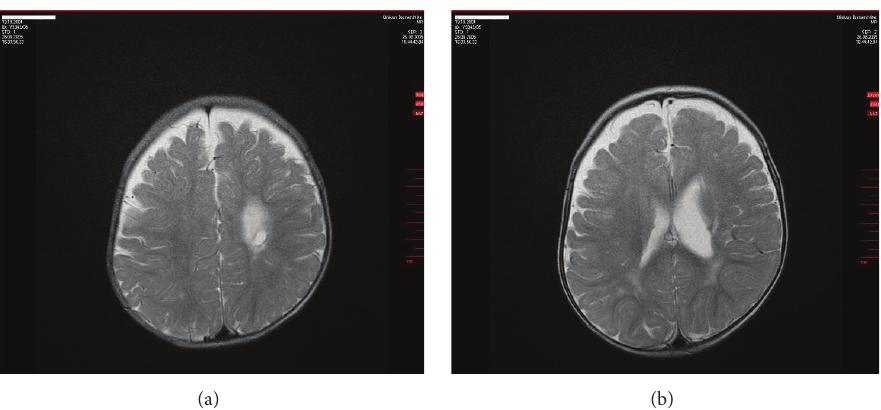
Figure 2: MRI of the brain (M.H.) at 10 months of age (2005). Left ischemic stroke in the central and paraventricular white matter resulting in a porencephalic cyst and enlarged lateral ventricle (1.5-Tesla Avanto, head coil array, T2w TSE sequence).